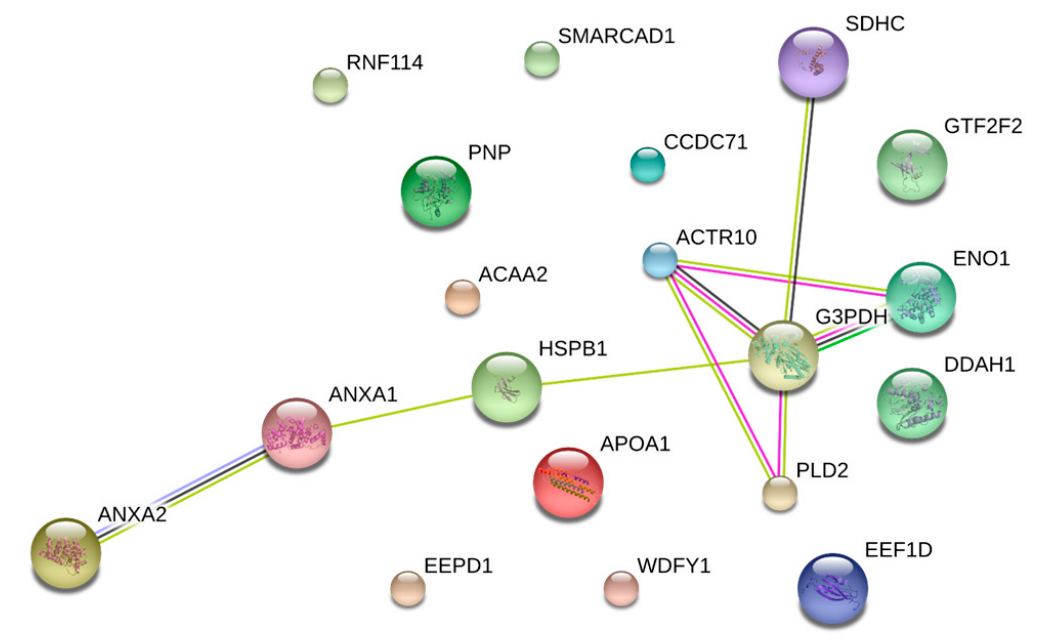
Figure 6. String protein-protein interaction analysis. The figure highlights the connections between differentially represented proteins.